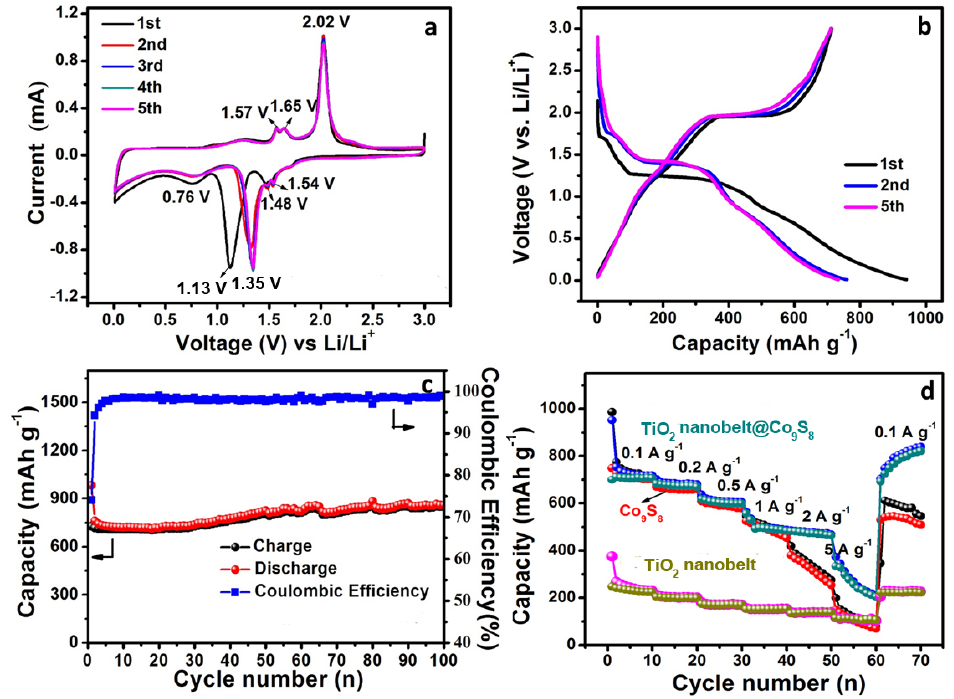
Figure 4. Cyclic voltammograms ( a ), galvanostatic discharge/charge profiles ( b ), cycling performances ( c ) of the TiO 2 nanobelt@Co 9 S 8 composites and ( d ) rate performances of the TiO 2 nanobelt@Co 9 S 8 composites, TiO 2 nanobelts and Co 9 S 8